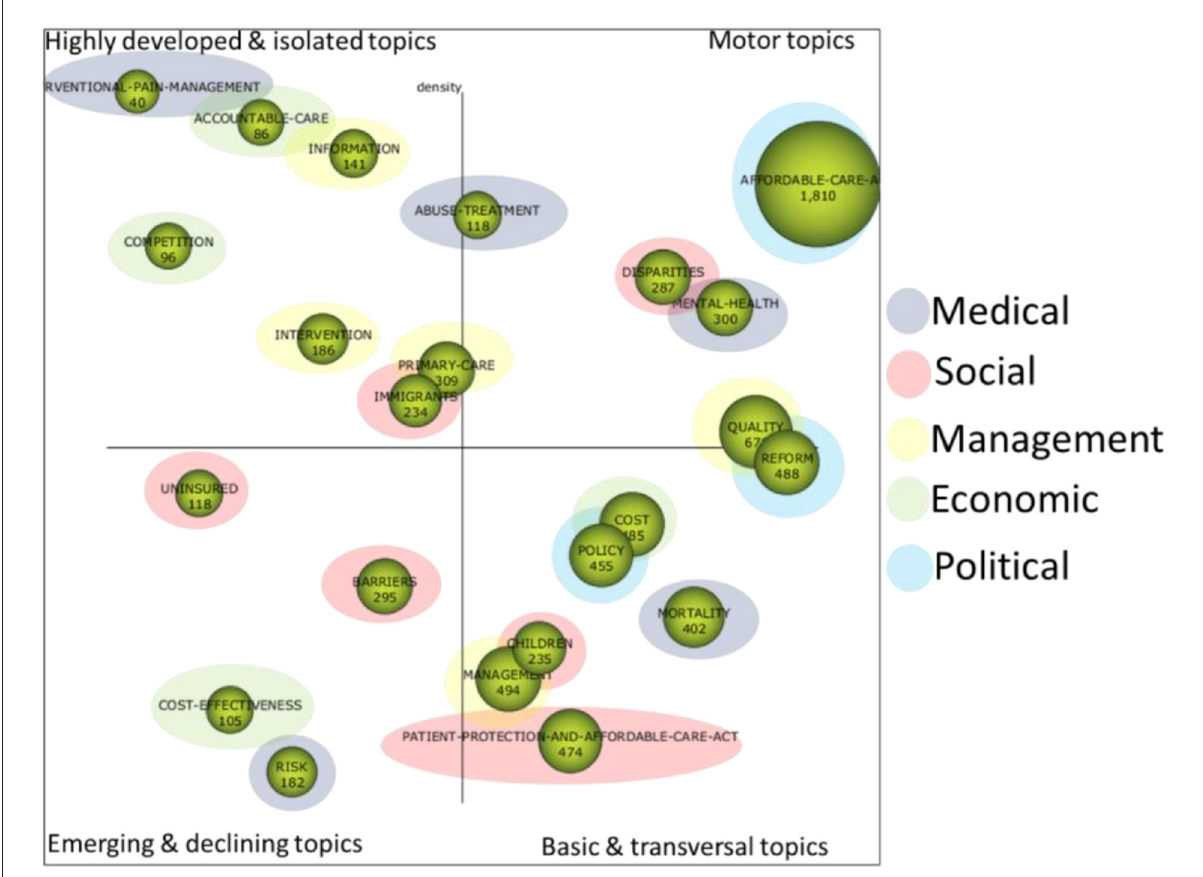
FIGURE4 Strategic diagram analysis period “until